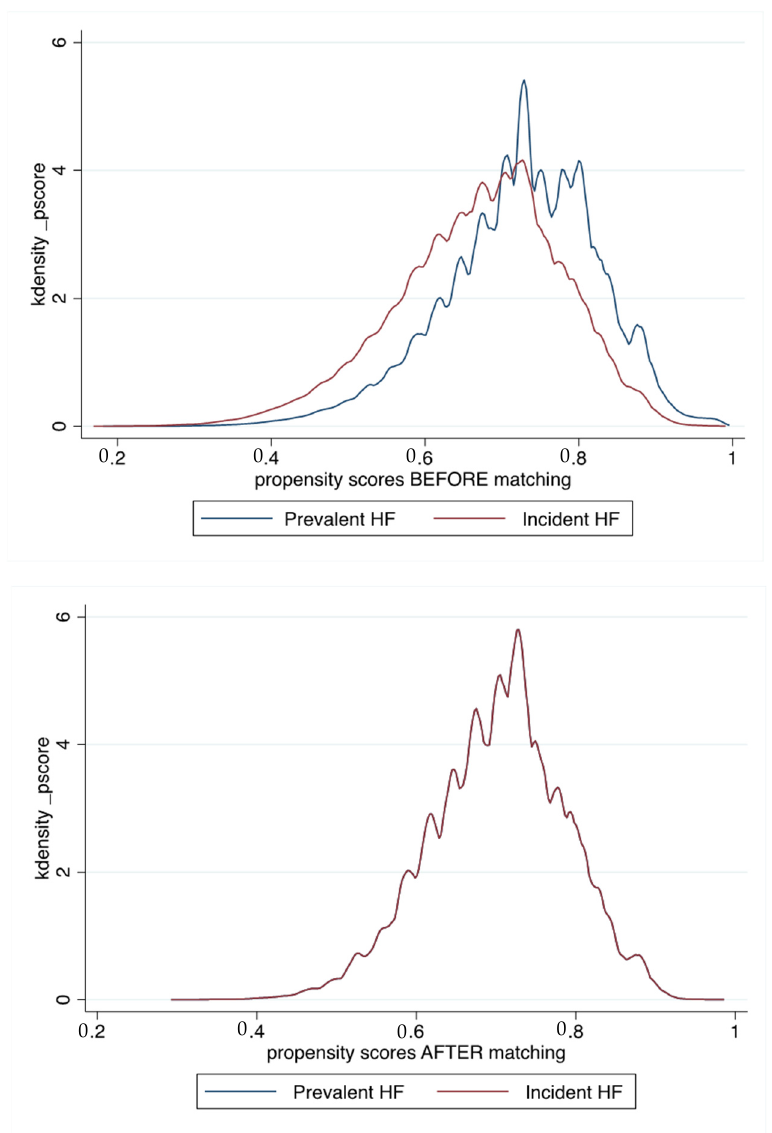
Figure 3. Propensity score distribution for unmatched and matched populations of patients with AF and HF, with incident HF and prevalent HF.